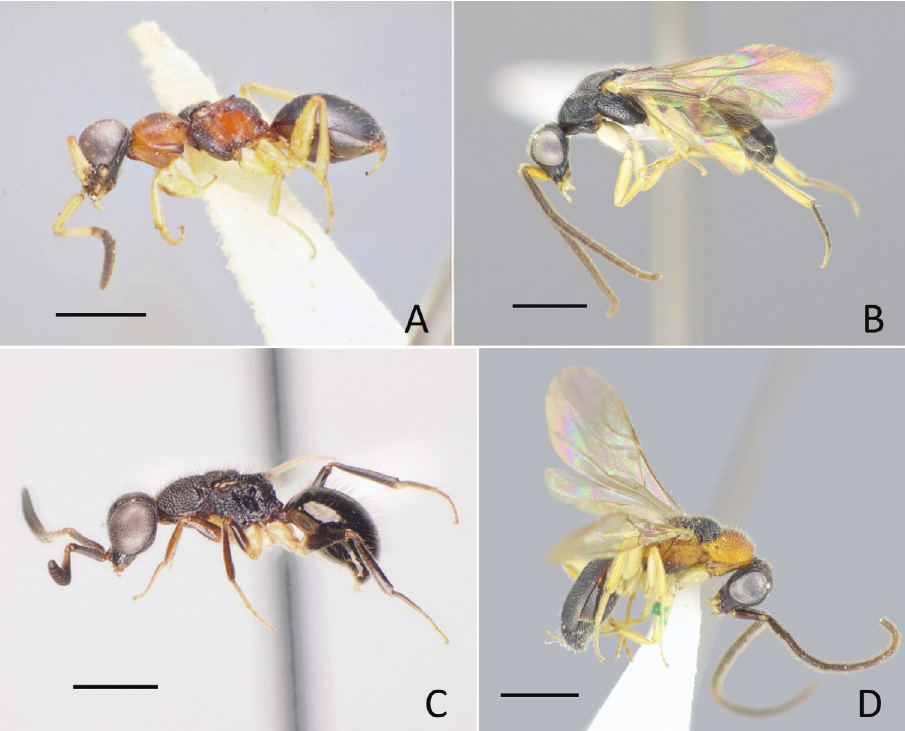
Figure 2. General habitus of Amiseginae A Nipponosega yamanei Kurzenko & Lelej, holotype ♀ B ditto, ♂ C Okinawasega eguchii Terayama ♀ D ditto, holotype ♂ . Scale bars: 1.0